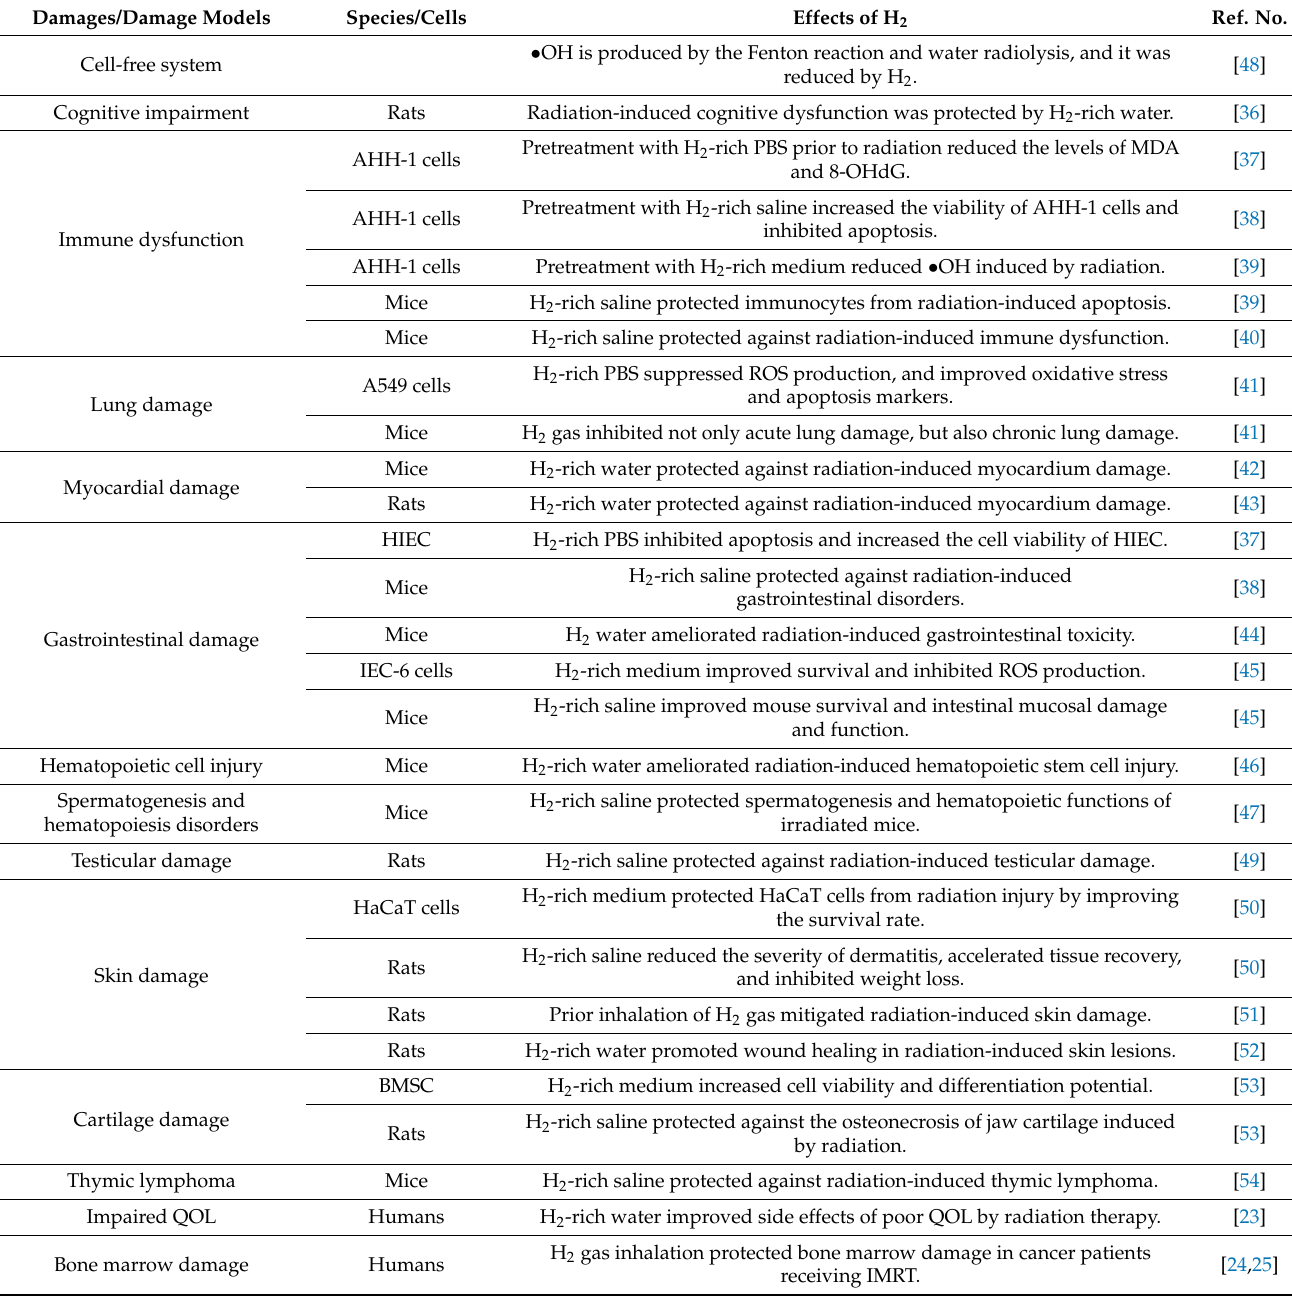
Table 1. Radioprotective effects of H 2 in cell free system, cells, animal models and clinical trials. Damages/Damage